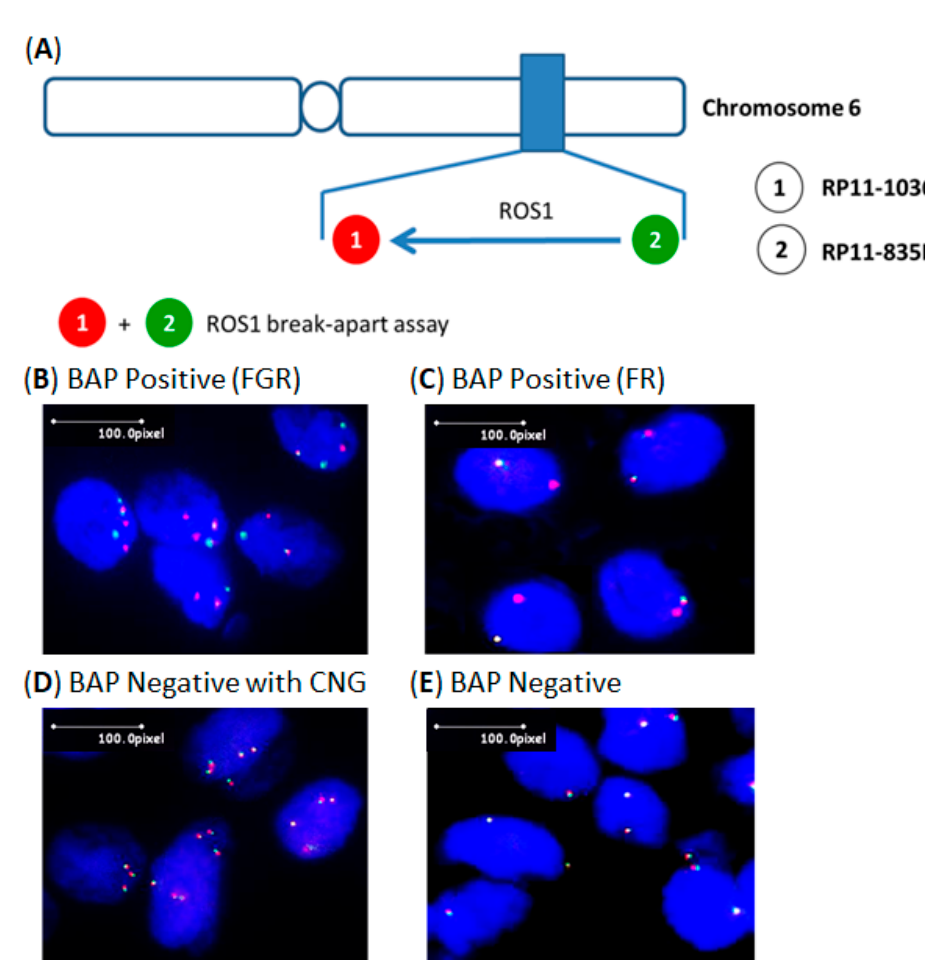
Figure 1. Detection of ROS1 translocation genes by FISH analysis. ( A ) Scheme of ROS1 break-apart probe construction. ( B ) Positive ROS1 translocation sample with classic combination of fused, green, and red signals (FGR pattern). ( C ) Positive ROS1 translocation sample with loss of isolated green signal (FR pattern). ( D ) Positive ROS1 translocation sample with copy number gain (CNG). ( E ) Negative ROS1 translocation sample. Table 1. Characteristics of ROS1 translocated and non-translocated groups in pre-crizotinib pe- riod.